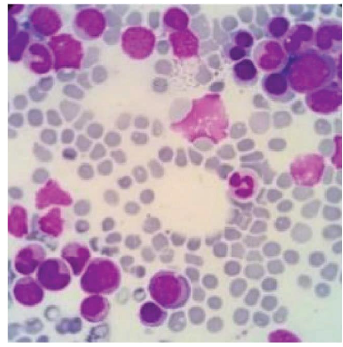
Figure 3: Bone marrow aspiration after 10weeks of antifungal treatment showed macrophages without